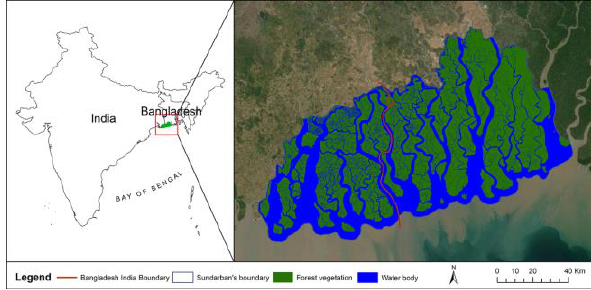
Figure 1. Sundarbans mangrove forest, including Bangladesh and Indian parts. The red line on the map indicates the international boundary between the two countries.